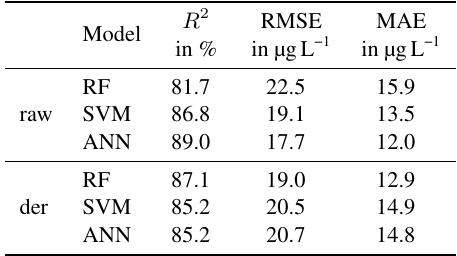
Table 3. Regression results for chlorophyll a estimation with 4nm spectral resolution for the raw dataset (raw) and the dataset with derivatives (der).